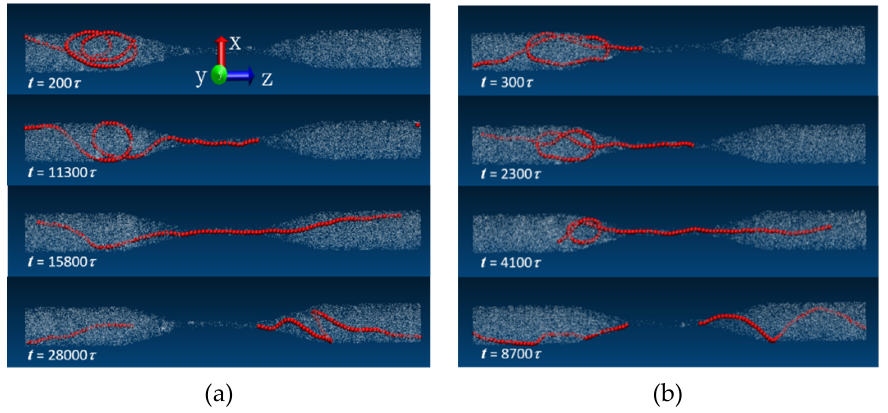
Figure 4. Translocation snapshots of linear chain ( a ) and trefoil knot chain ( b ) with time variation, respectively, where the rigidity b = 100 and the chain length n = 100.